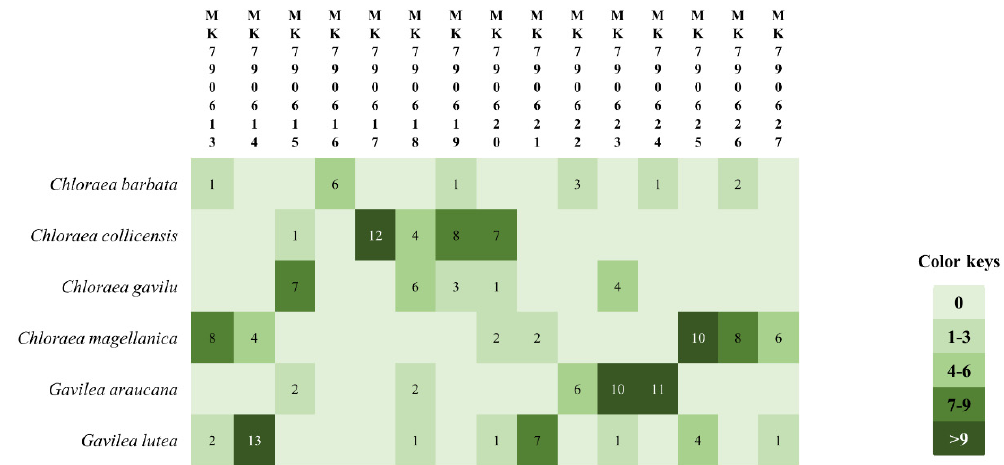
Figure 1. Heat map of abundance of bacterial strains isolated from peloton-containing roots. Most of the obtained isolates belonged to the phylum Proteobacteria. The isolates GA02, GL01, GL02, GA03, CM04, GA01, CM03, and CB01 showed high similarity with strains from the order